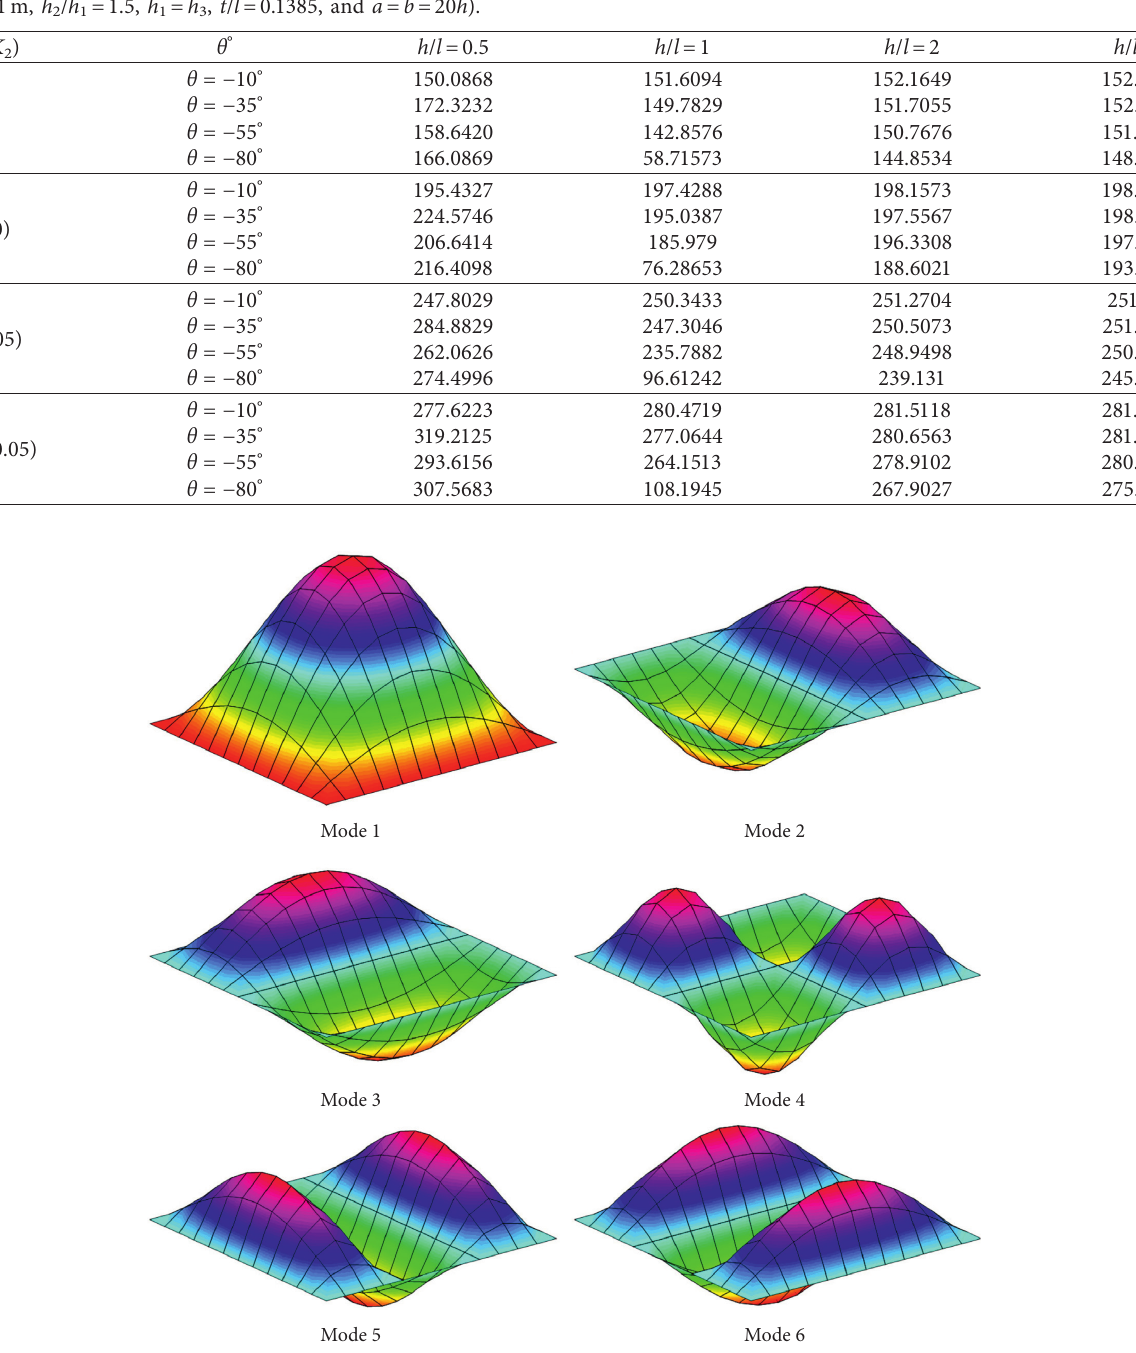
Figure 6: The first six mode shapes of the SSSS plate with h � 0.1m, h